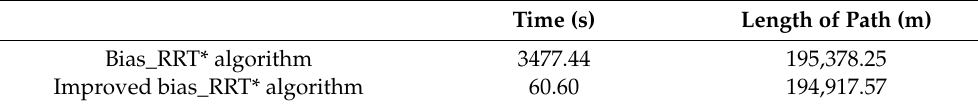
Table 2. Bias_RRT* algorithm comparison to improved bias_RRT* algorithm in Scenario 1.